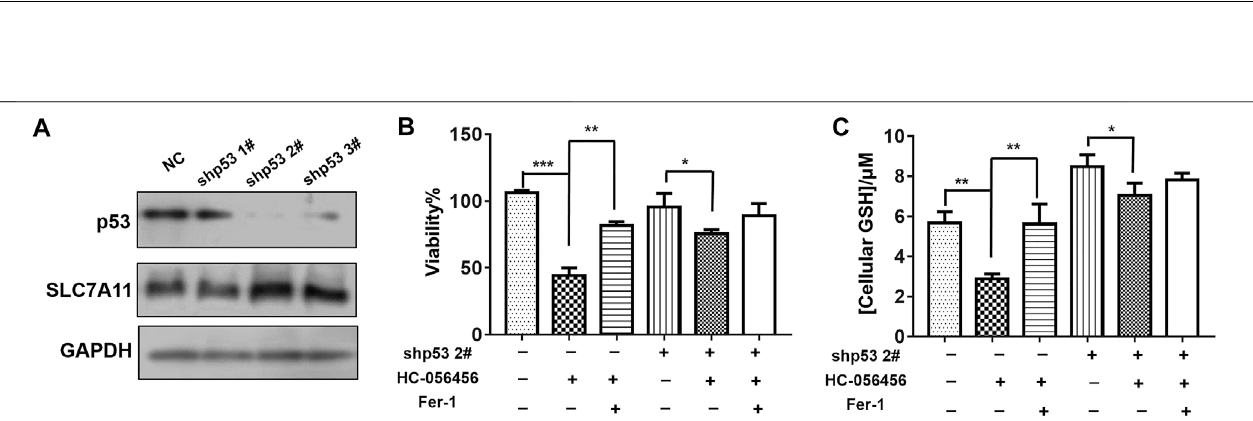
FIGURE 6 | HC-056456 enhanced the expression of p53 and downregulated SLC7A11 in MGC-803 cells (A) MGC-803 cells were treated as indicated for 24 h. WesternBlotdetectedtheexpressionofp53andSLC7A11 (B) ThemRNAlevelsofp53and (C) SLC7A11wereanalyzedbyRT-PCR.* p < 0.05,** p < 0.01,*** p < 0.001 versus control group.